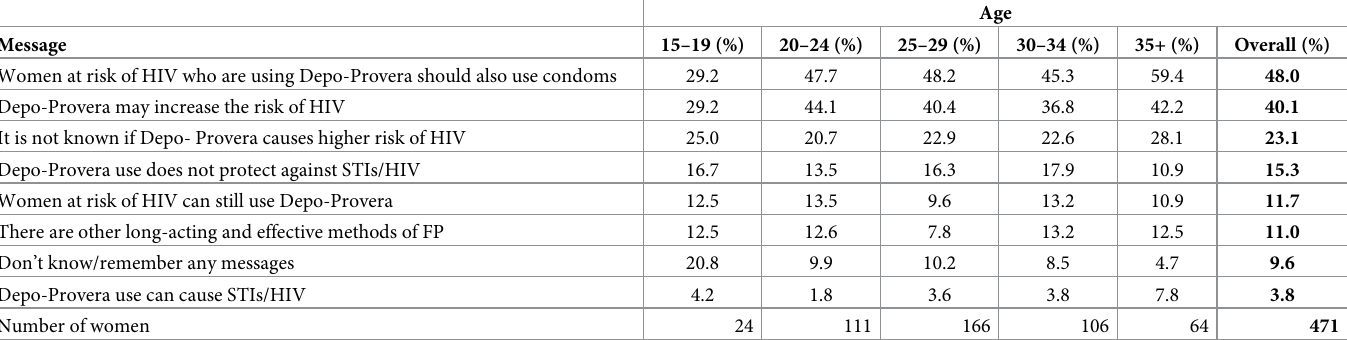
Table 4. Spontaneous mention of messages related to Depo-Provera and HIV acquisition percentage of women 17–49 who spontaneously recalled various messages from counseling on Depo-Provera and potential increased risk of HIV acquisition, by age group, Tanzania